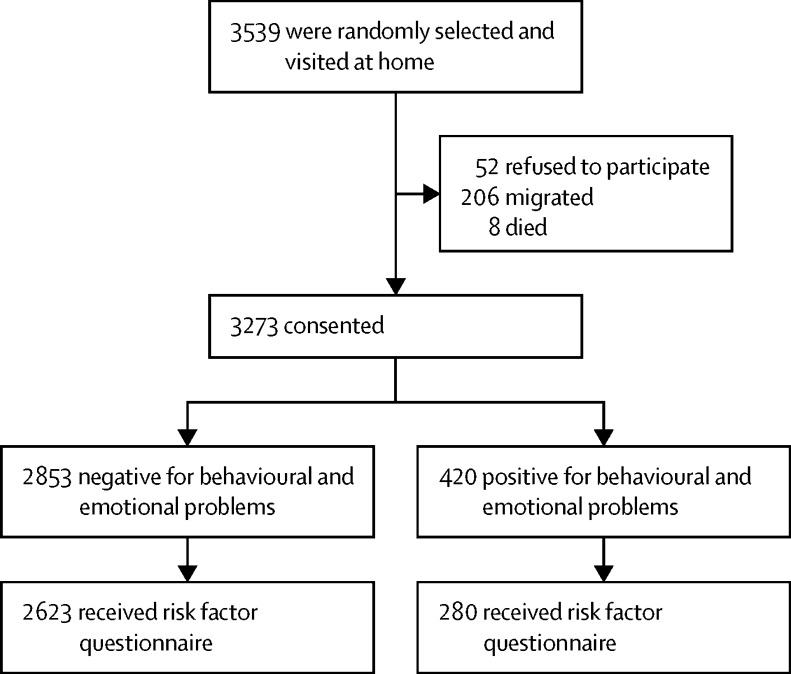
Derivation of the sample for the behavioural and emotional surveyFieldworkers visited 3539 children in their homes, of whom 3273 (93%) consented to take part in the epidemiological survey.